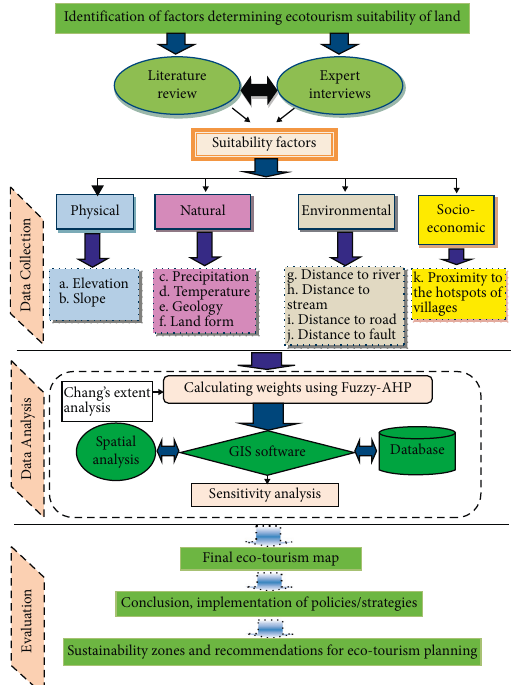
Figure 1: Structure of the proposed FAHP